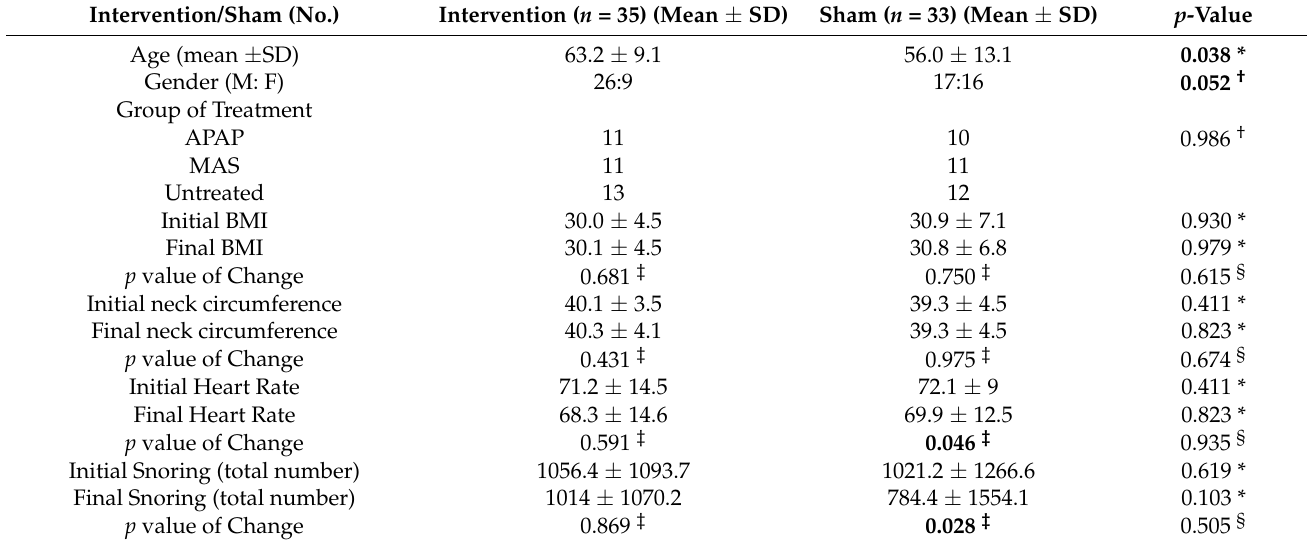
Table 1. Characteristics of participants according to allocation to intervention and Sham